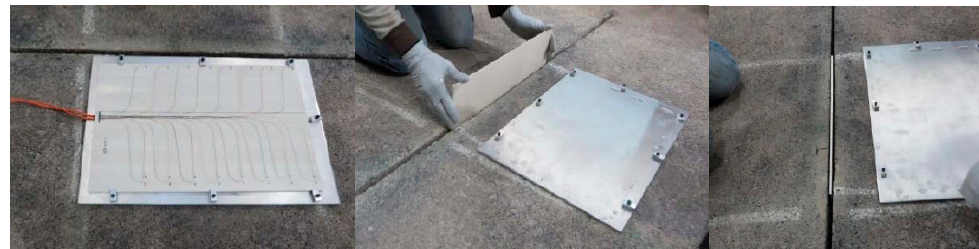
Figure 5. Instrumented plate installation at the Federal Aviation Administration (FAA) National Airport Pavement Test Facility (NAPTF) in Atlantic City, New Jersey, USA (figures are reproduced from Garg et al. [45]).